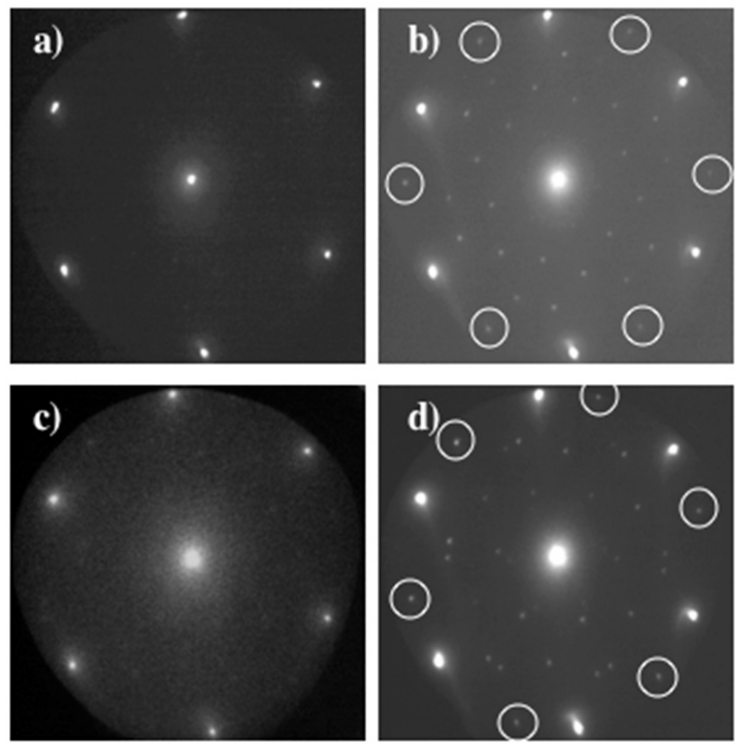
Figure 6. ( a ) to ( d ), LEED patterns from a hydrogenated sample at an energy of 45 eV and a probing area of 1.5 μ m. The pattern was found to change from the (1 × 1) in ( a ) to that in ( b ), containing superstructure spots within a minute. When moving to another spot on the sample and using a low electron beam current, the 1 × 1 pattern in ( c ) was observed. When increasing to the high electron beam current, the pattern in d) appeared within a minute. Using electron energies of 80 eV and 142 eV resulted in the patterns shown in ( e ) and ( f ),